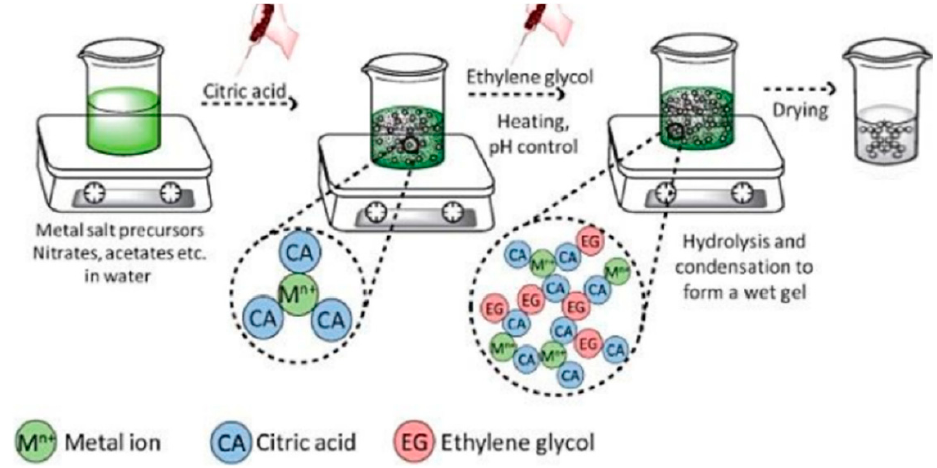
Figure 15. Steps in the sol–gel process to achieve final morphologies (Adapted from [60]).